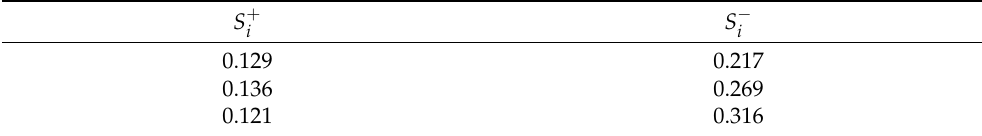
Table 4. The weighted separation measures between alternatives and ideal solutions.